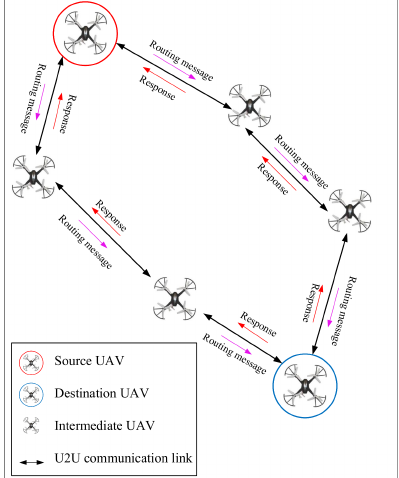
Figure 21. Distributed routing scheme. Table 6. Comparison of centralized and distributed routing